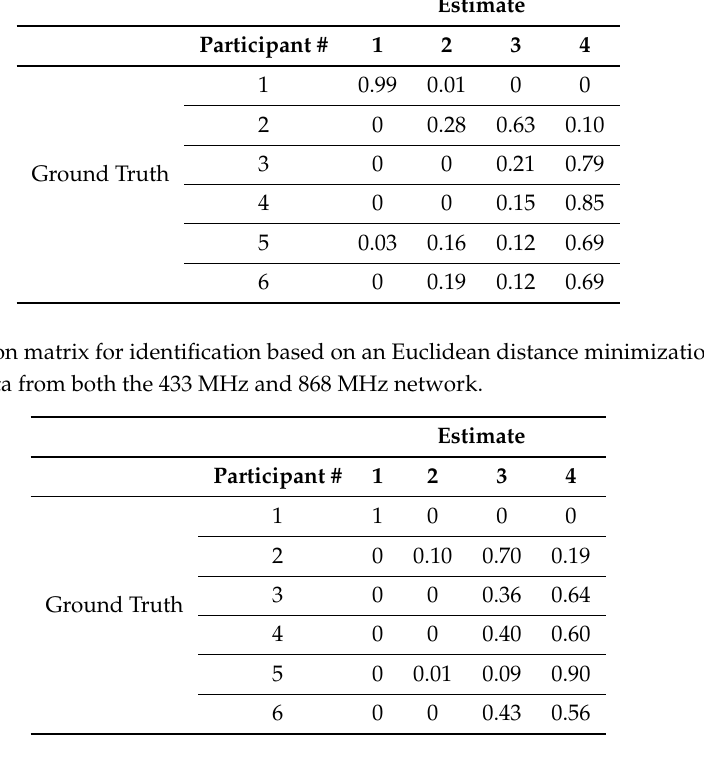
Table 15. Confusion matrix for identification based on a naive Bayesian classifier approach applied to RSS data from both the 433 MHz and 868 MHz